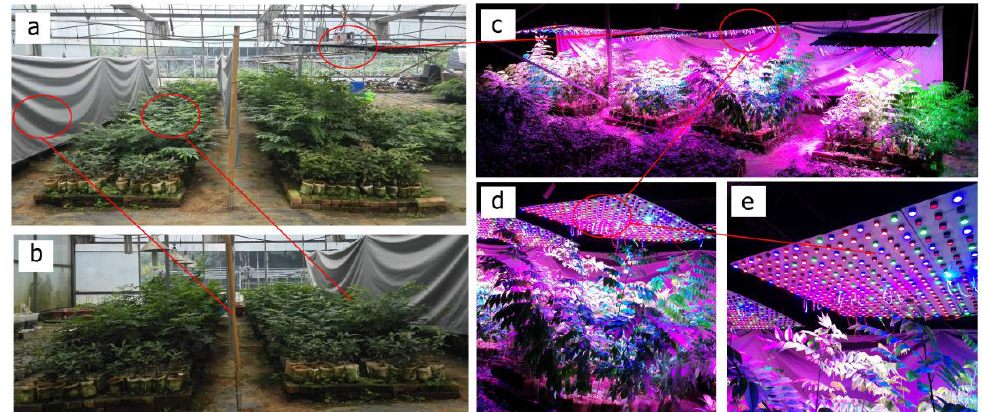
Figure 1. A scene of Fragrant rosewood ( Dalbergia odorifera ) seedlings cultured under the control, light-emitting diodes (LED) ( a ), and high-pressure sodium (HPS) lightings ( b ) at the day of seedling sampling. ( c ) A scene of LED lighting on Fragrant rosewood seedlings under the panels ( d ) with diodes inlaid ( e ) during night time of the late-period of seedling culture.